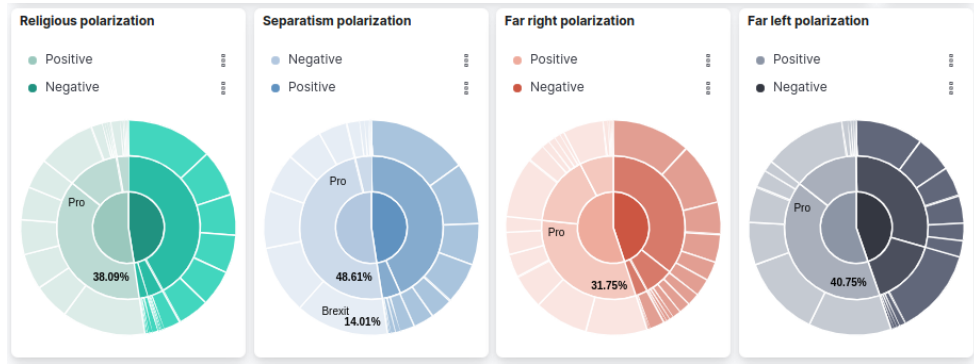
Figure 9. Overview of the interface. Part II. Pie charts.